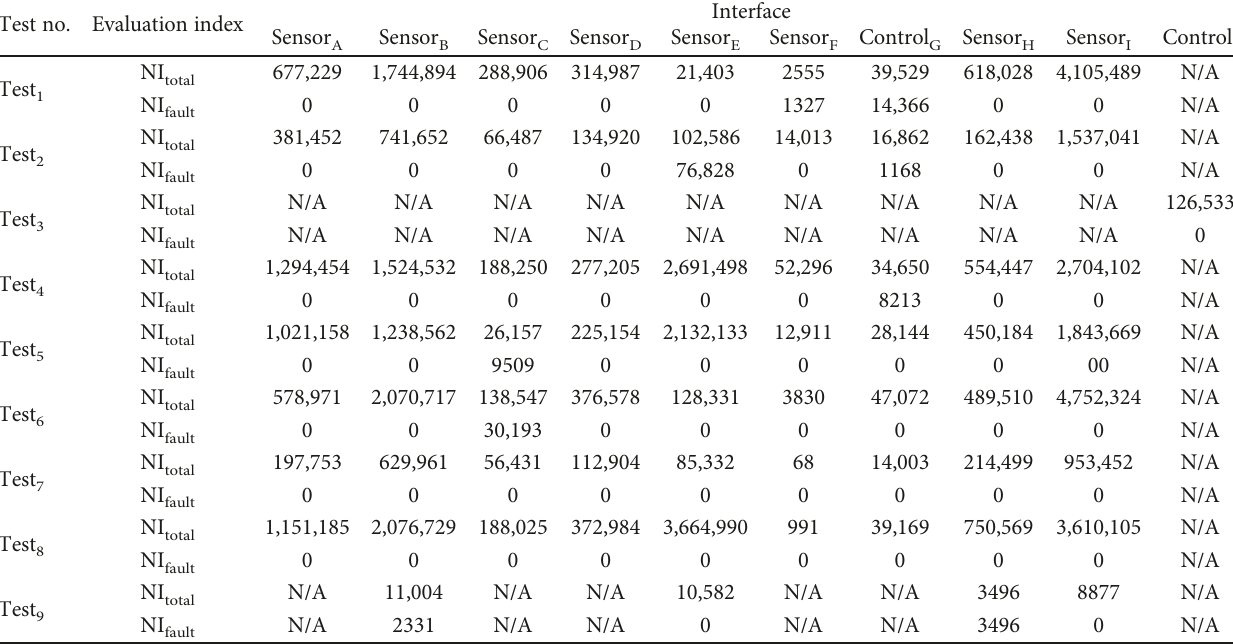
Table 7: Overall test results: fault-detection results.